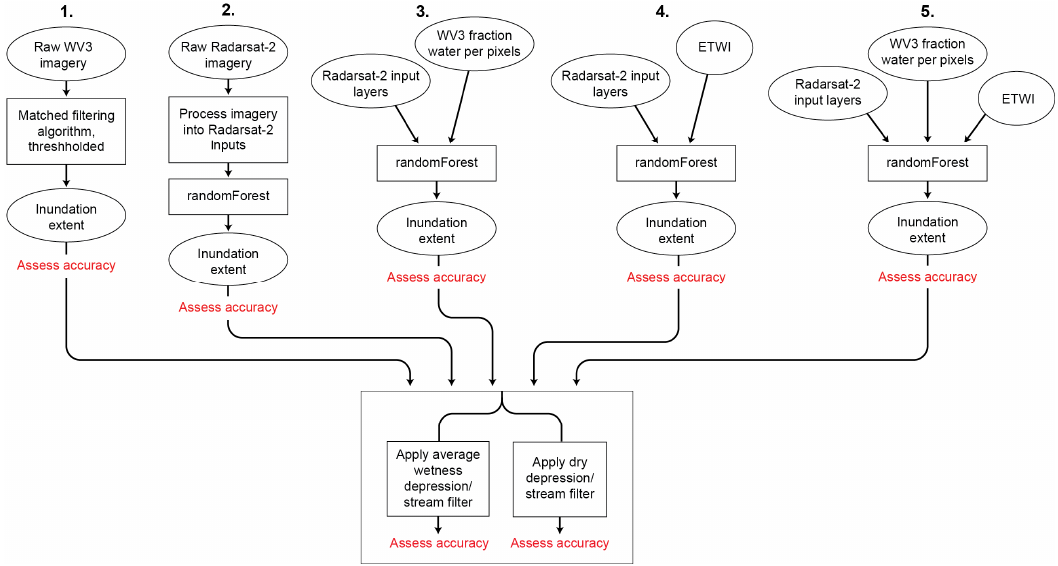
Figure 4. Flowchart of accuracy assessment. WV3: Worldview-3. ETWI: enhanced topographic wetness index.